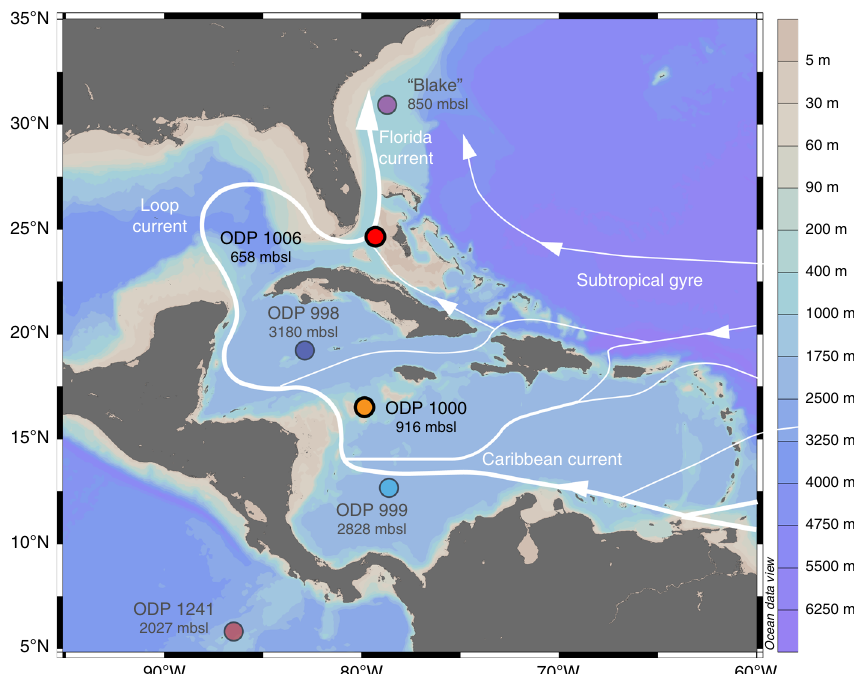
Fig. 1 Study area and sample sites. Locations and water depths of Ocean Drilling Program (ODP) Sites from which the new data were obtained (1000 and 1006) and of other sites referred to in this study (ODP 998, 999 and 1241, Blake crust). The main ocean currents affecting the sites are shown in white 35, 36, 61 . Map produced using Ocean Data View